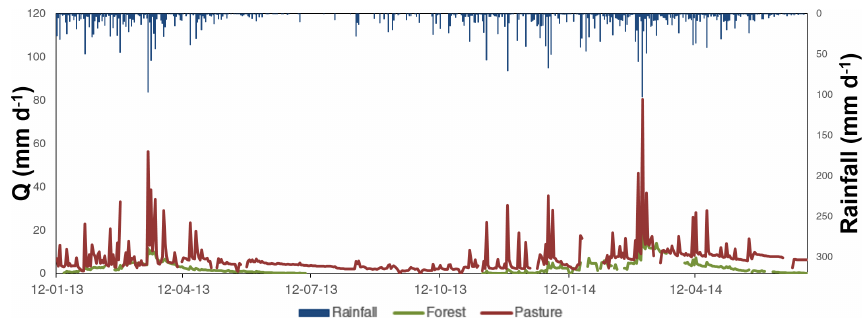
Figure 3. Streamflow and rainfall in the forest and pasture micro-catchments.